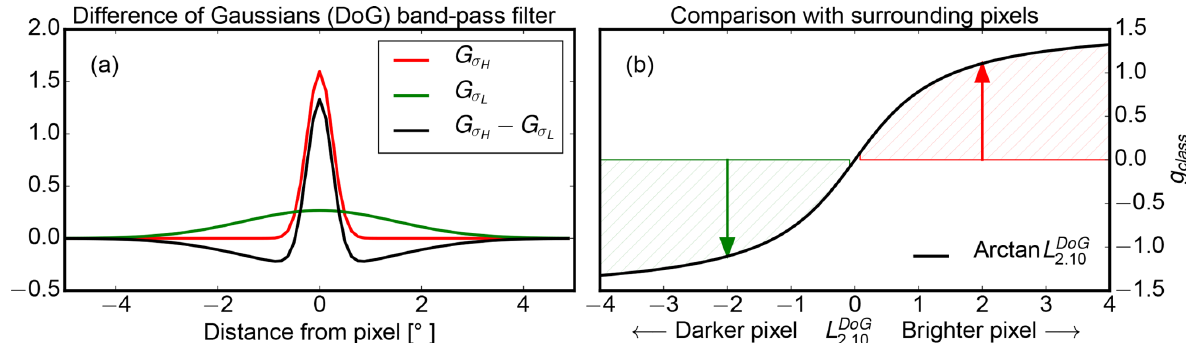
(red) and G σ (green) which is used as a filter to derive (b) . The gradient classifier g class H L